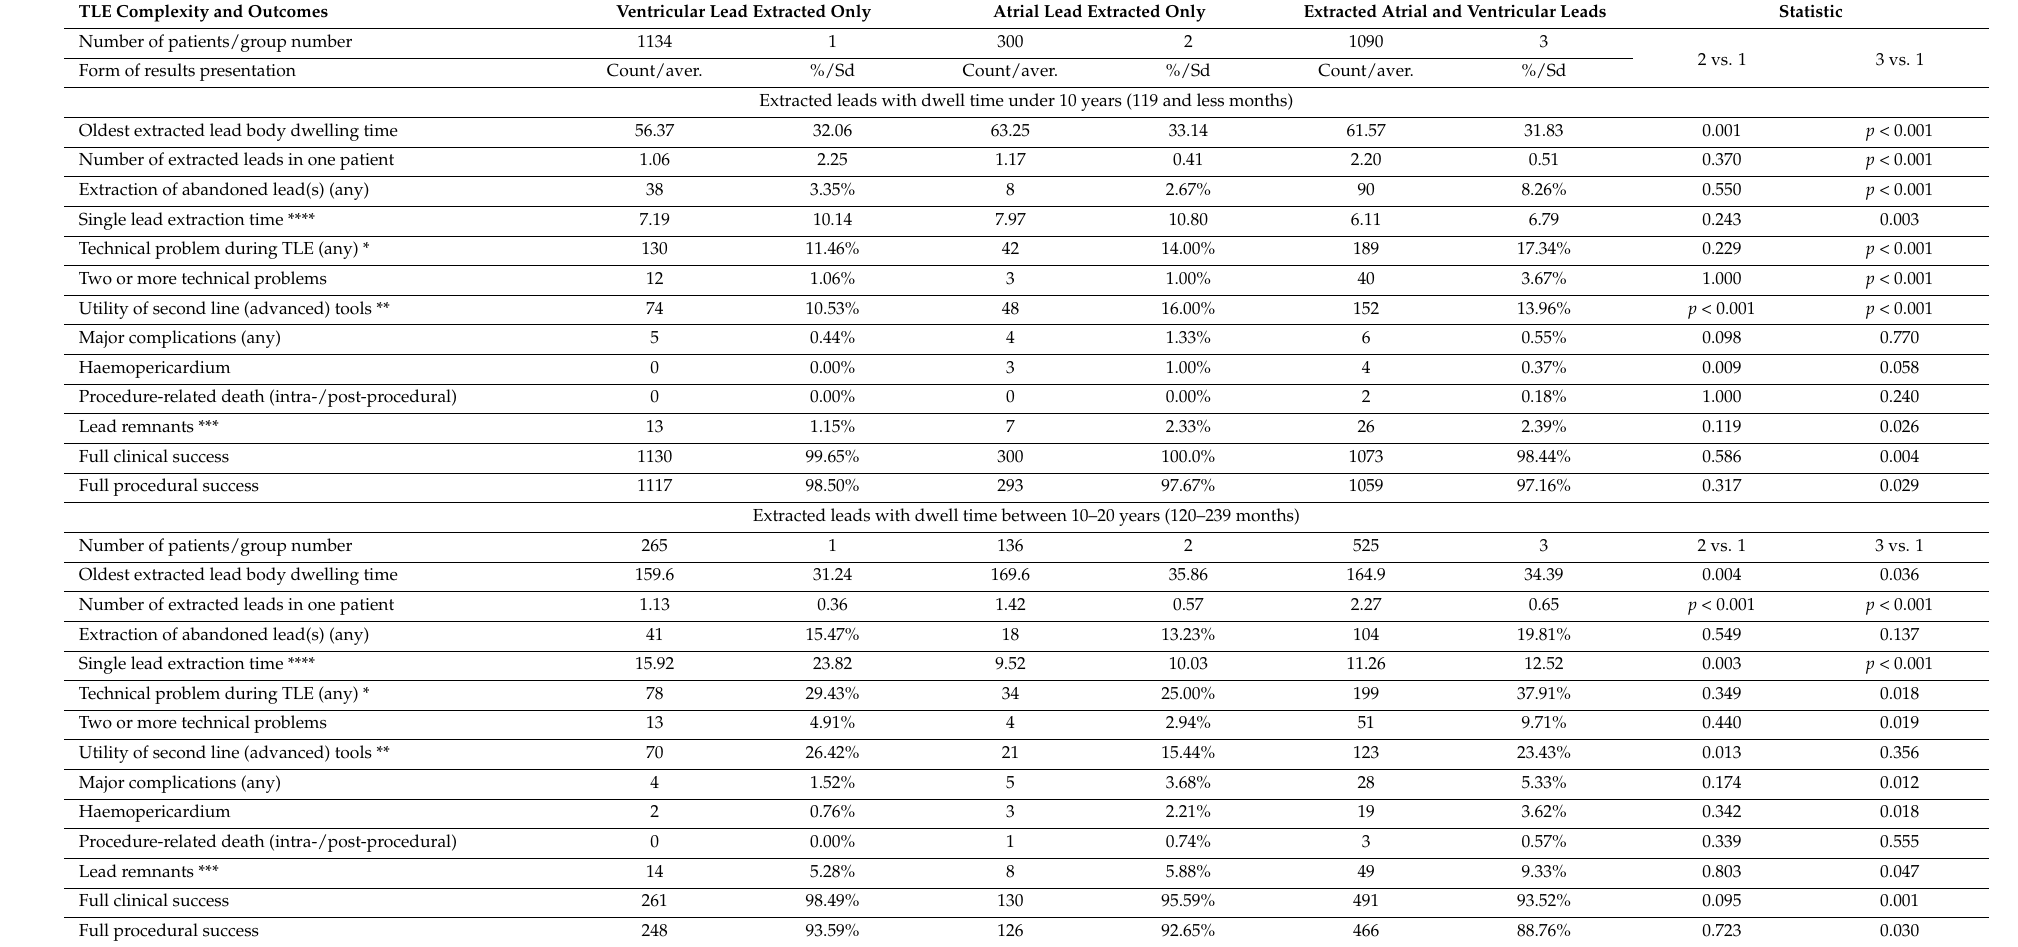
Table 5. TLE complexity and outcome in four analysed groups taking into accounts kind of extracted